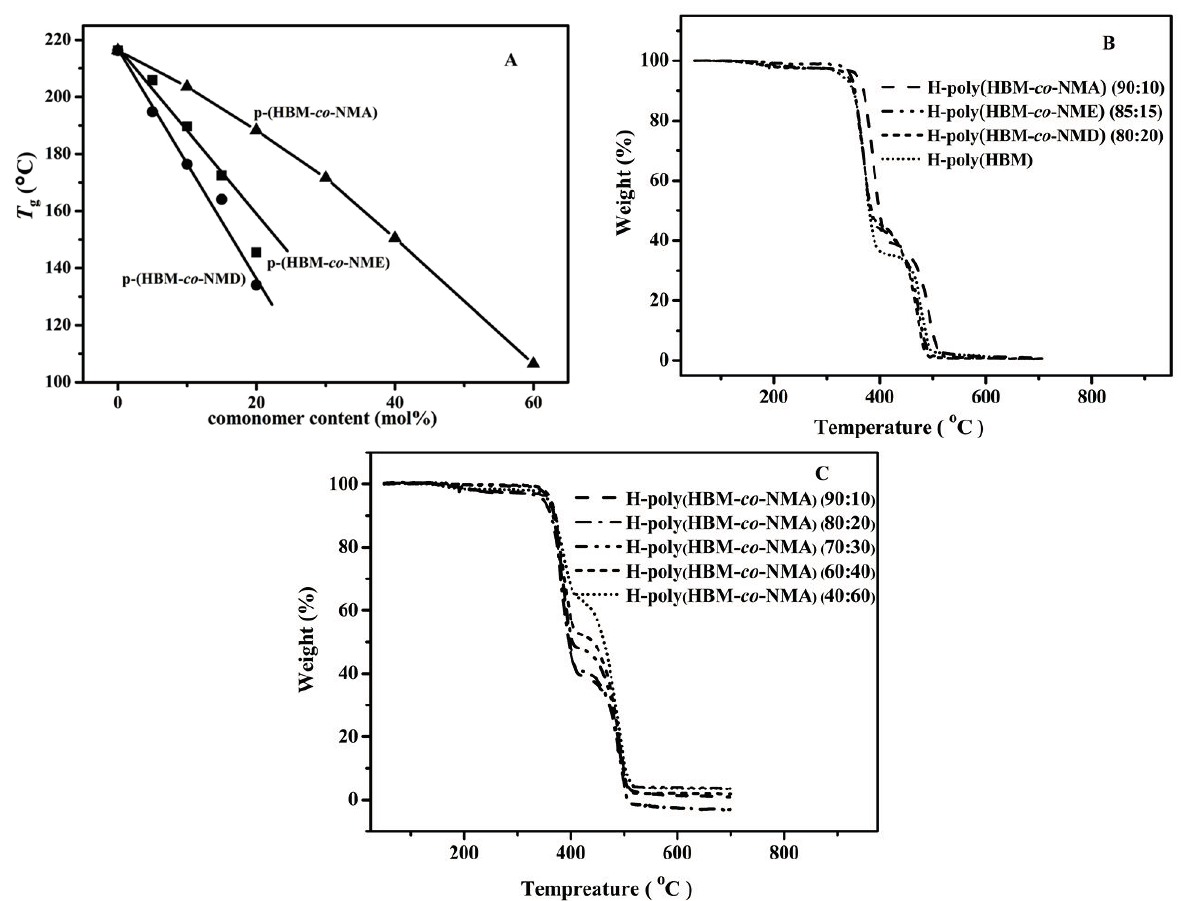
Figure 2. ( A ) plots of T g of the copolymer vs. comonomers incorporation; ( B ) TGA curves of the copolymers of HBM with different comonomers in N 2 ; ( C ) TGA curves of the copolymers of HBM with NMA in N 2